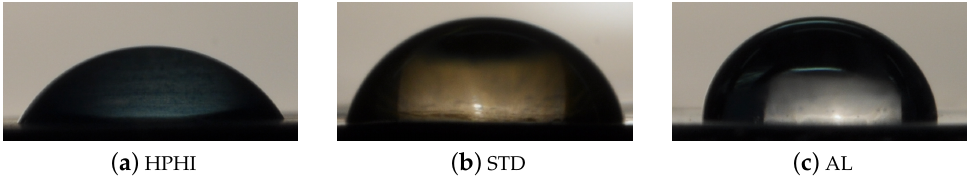
Figure 1. Examples of sessile drops on the three different surfaces investigated in horizontal